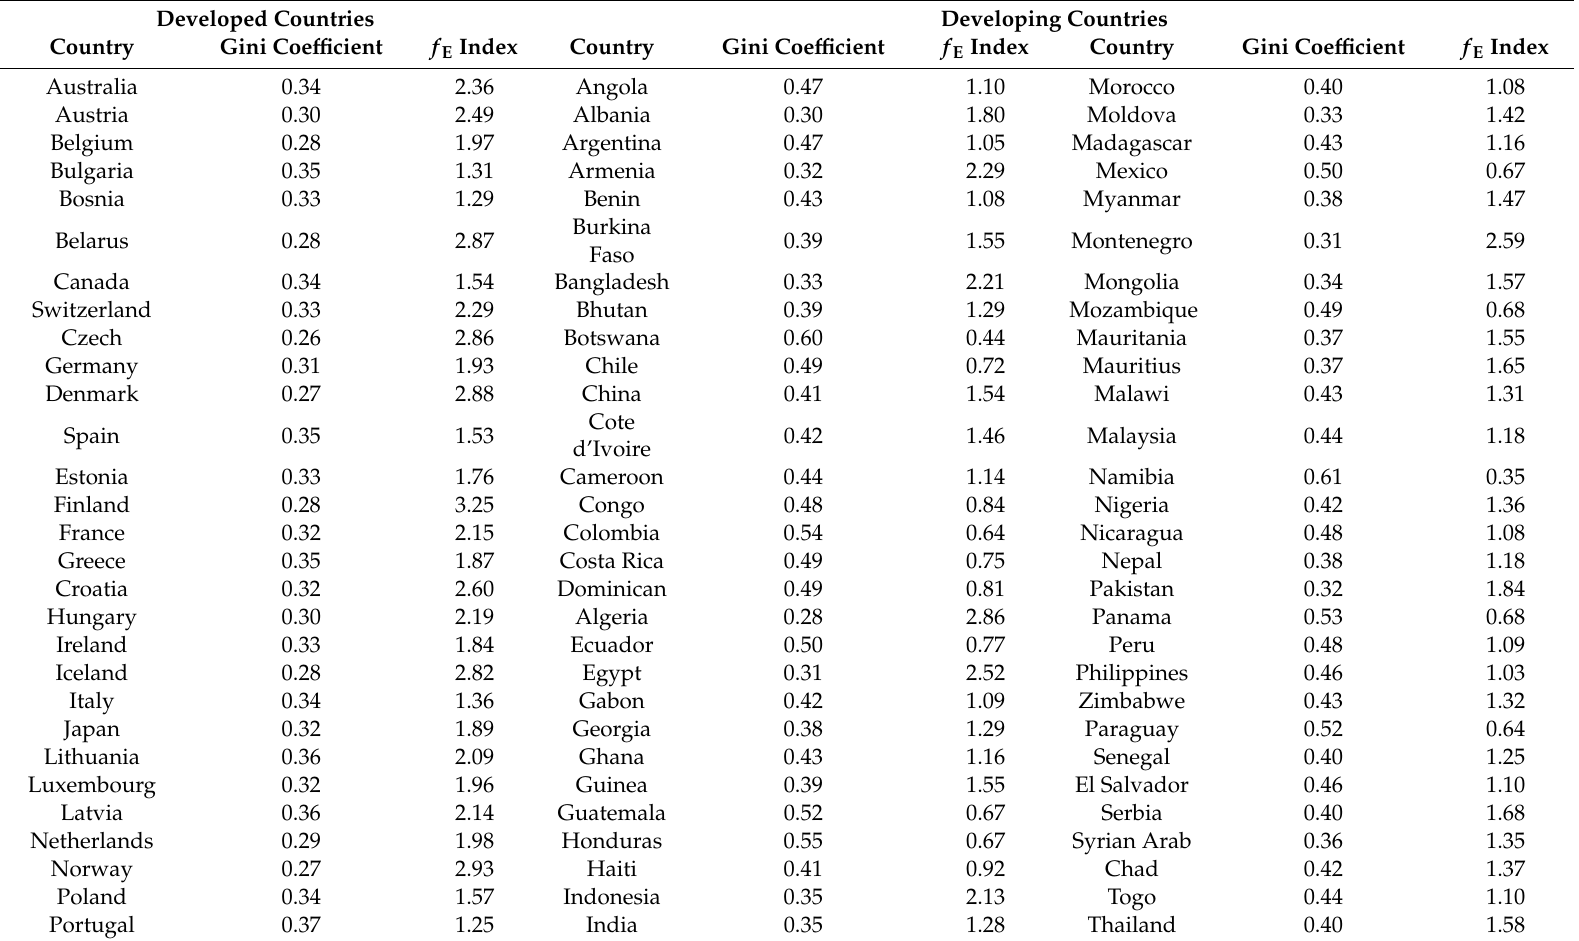
Table A2. The f E index and income Gini coe ffi cients in di ff erent